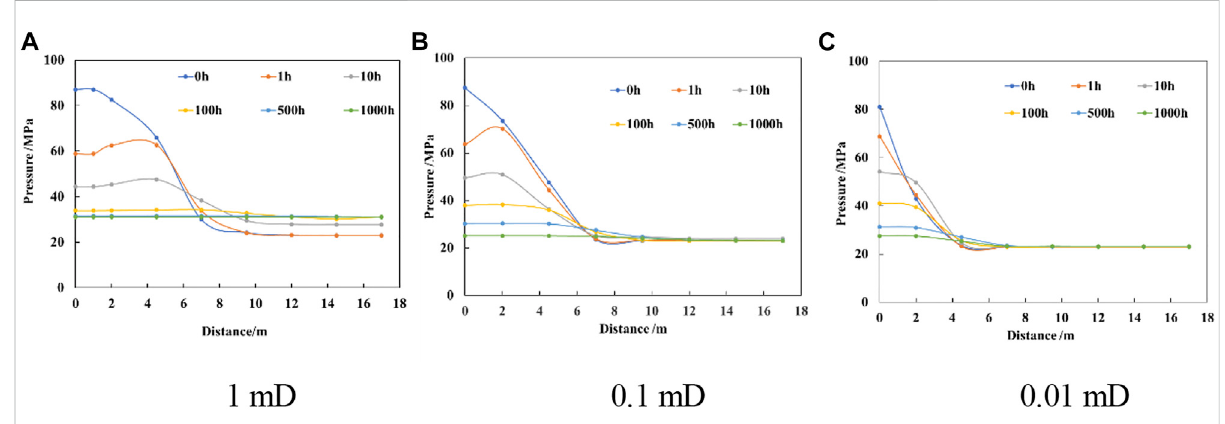
FIGURE 16 Pressure of the main fracture at different transverse distances in different permeability zones. (A) 1 mD, (B) 0.1 mD, and (C) 0.01 mD.